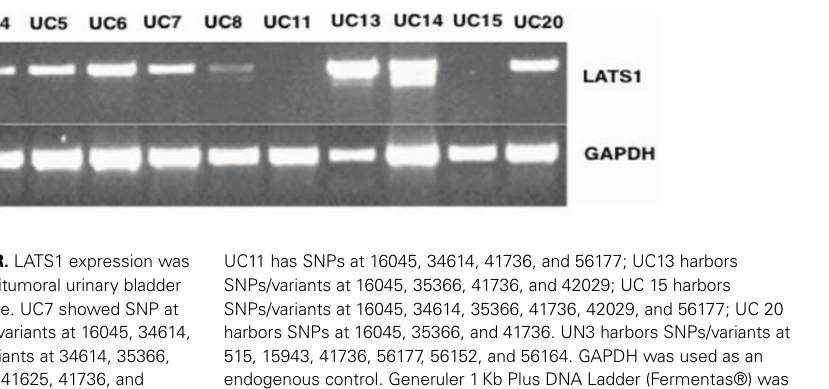
UC11 has SNPs at 16045, 34614, 41736, and 56177; UC13 harbors SNPs/variants at 16045, 35366, 41736, and 42029; UC 15 harbors used as a size marker.